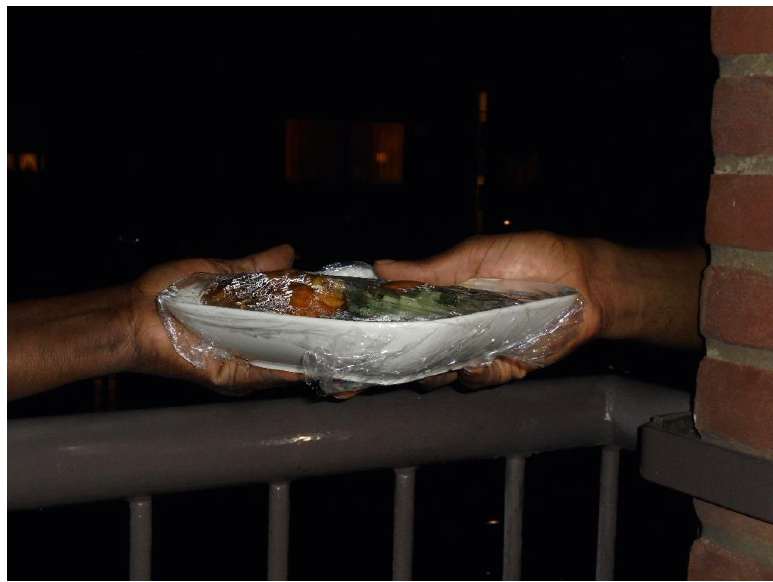
Figure 2. Photograph of community researcher handing over food to her son, titled: “ my duty, unconditional love and care, thankful ” .